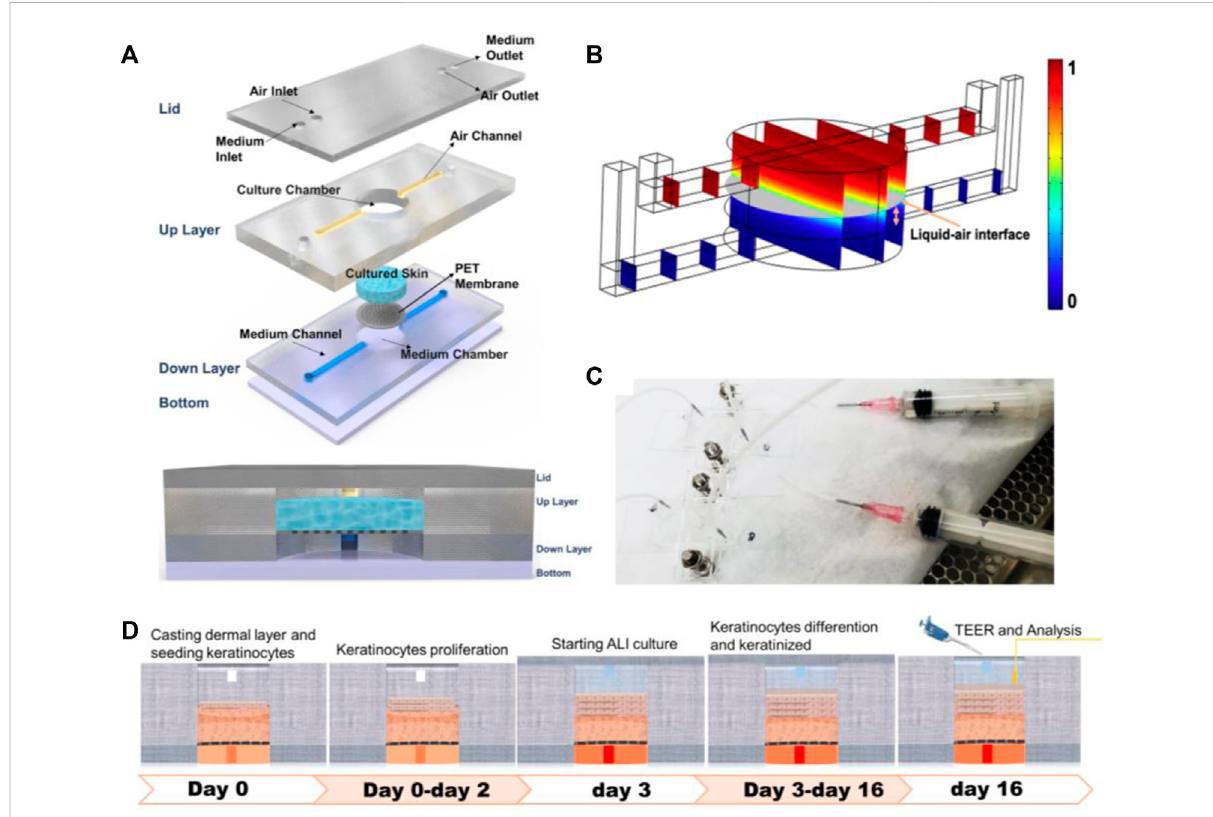
FIGURE 1 Design and simulation of IC-SoC. (A) Exploded view of the IC-SoC device composed of four major layers and a membrane. (B) COMSOL Multiphysicssimulationofair-liquiddistributioninthemicrochannels.Thegrayplanerepresentstheair – liquidinterface,andthecolorbarshowsthe volume fraction of air. (C) Appearance of IC-SoC connected with the fl uid injector. (D) Schematic overview of the full-thickness skin culture on chip from IC-SoC cross section and in vitro assay